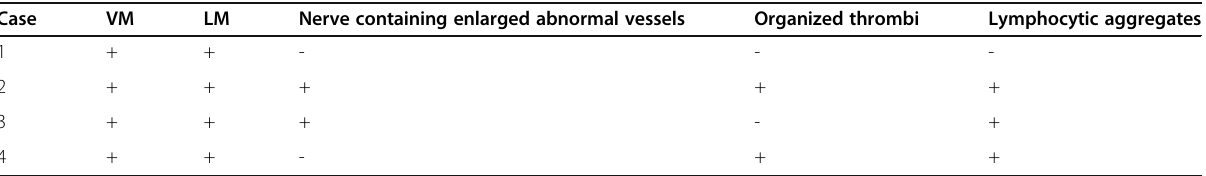
Table 2 Summary of histological findings Case VM LM Nerve containing enlarged abnormal vessels Organized thrombi Lymphocytic